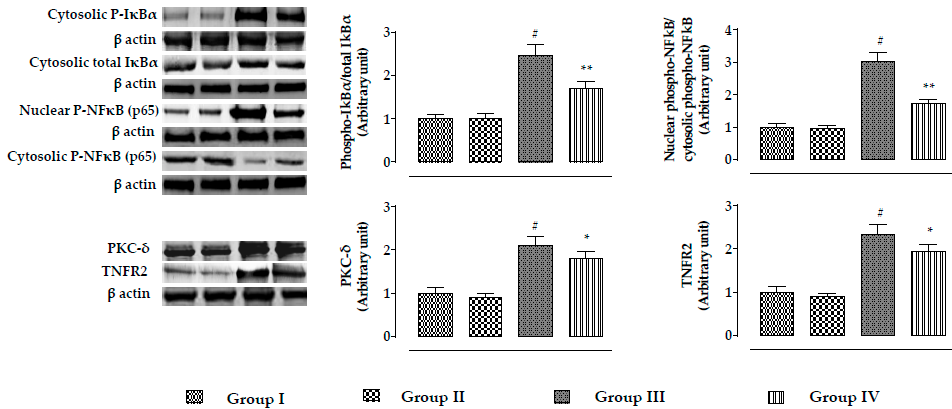
Figure 10. The e ff ects on NF- κ B, PKC- δ , and TNFR2 expressions in the absence (CdCl 2 ) and presence of RA (CdCl 2 + RA) in vivo on mouse kidneys. The relative band intensities were assessed, and the intensity of the normal control band was assigned as 1. β -Actin served as the loading control. Data are represented as means ± SD, n = 6 (number of plates). # Values significantly ( p < 0.01) di ff er from normal control. * Values significantly ( p < 0.05) di ff er from CdCl 2 control. ** Values significantly ( p < 0.01) di ff er from CdCl 2 control.